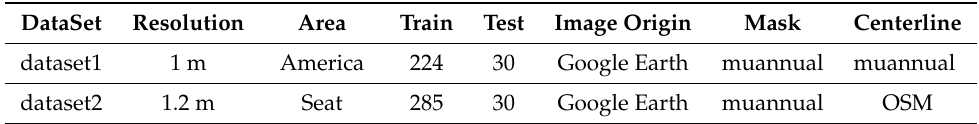
Table 1. Dataset